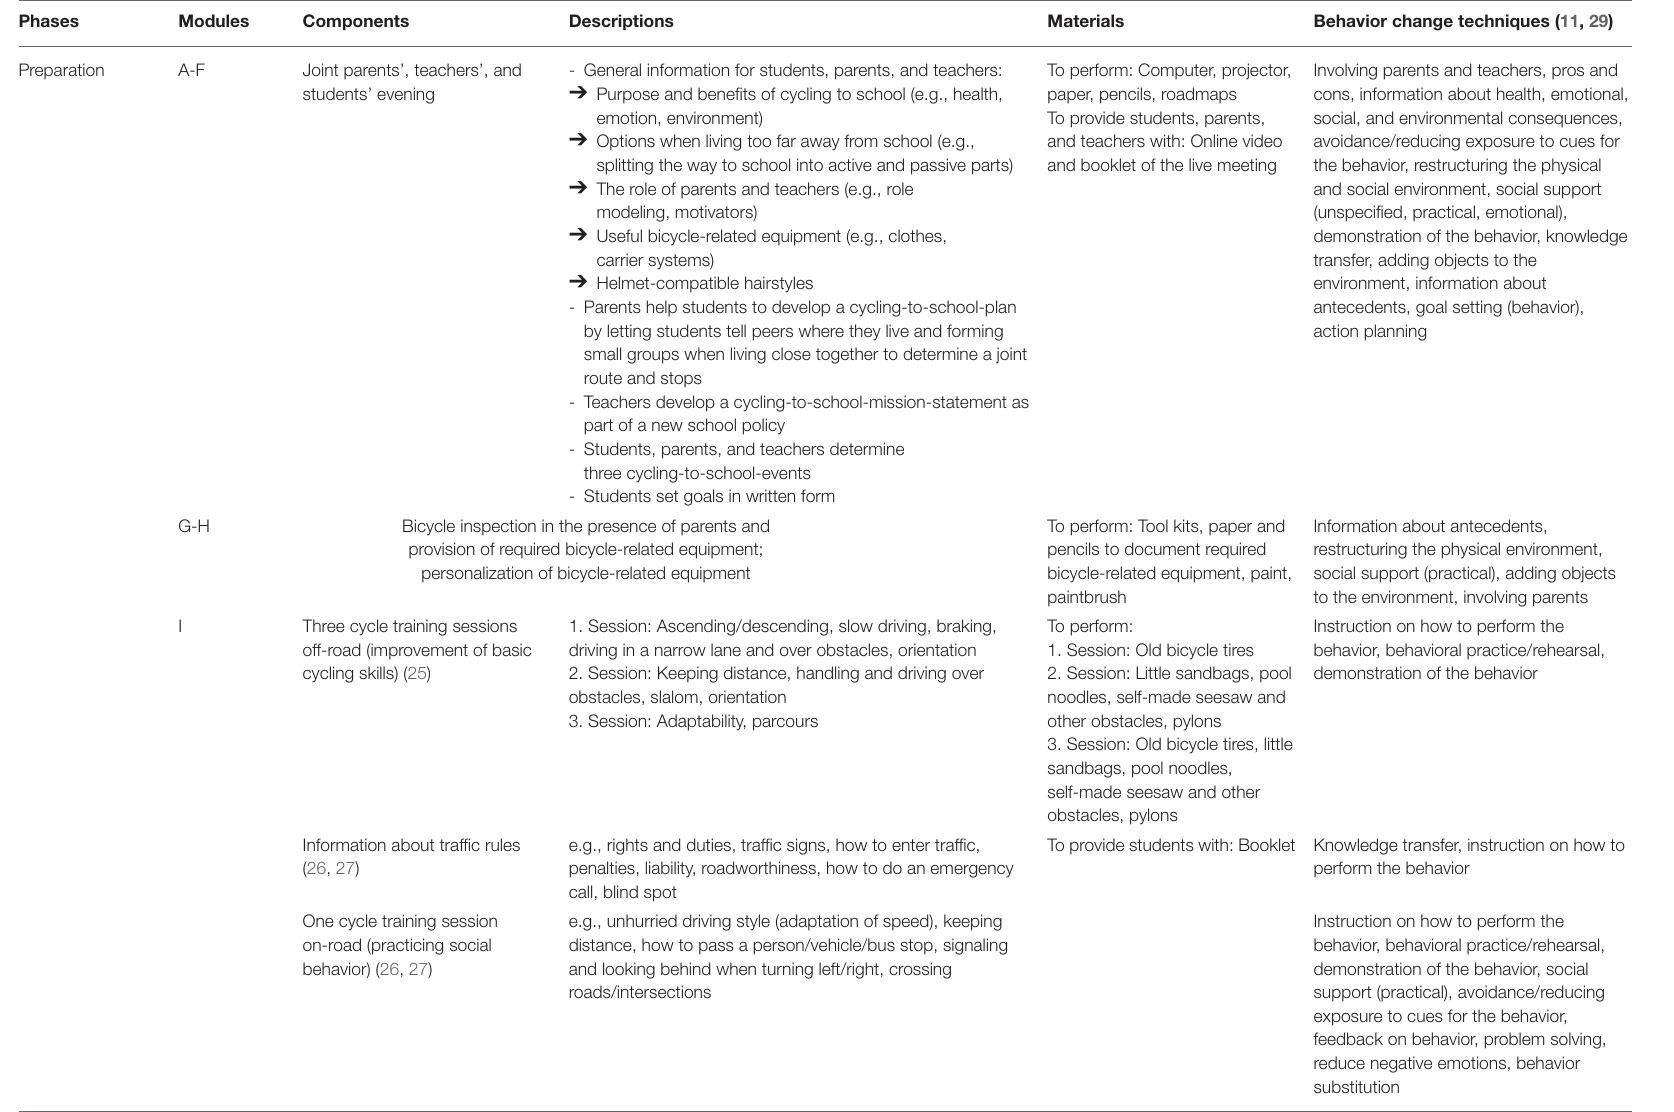
TABLE 2 | Program design. Phases Modules Components